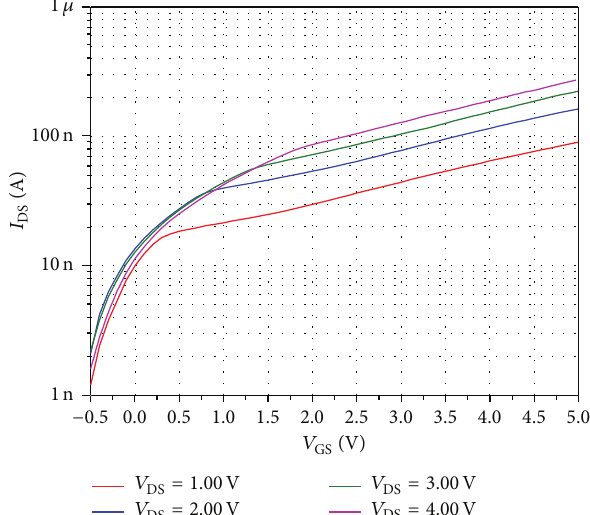
Figure 4: Transfer characteristics 𝐼 DS versus 𝑉 GS for GRC device with following specifications: 𝑡 Si = 2.2 nm and 𝑊/𝐿 = 80 𝜇 m/3 𝜇 m, 𝑇 = 77K.